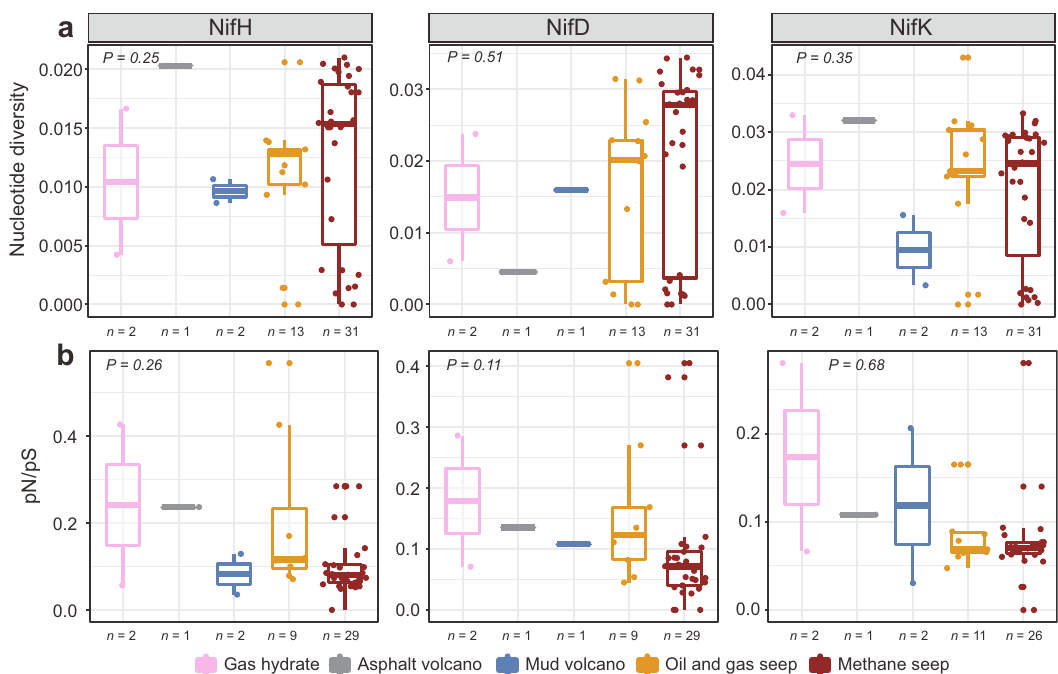
Fig. 7 | Evolutionary metrics of nitrogen fi xation genes. a Nucleotide diversity ( π ) of nifHDK genesatdifferent typesof coldseeps; b pN/pS ratio of nifHDK genes at different types of cold seeps. Nucleotide diversity is used to measure genetic diversity within a population (microdiversity), which is calculated using the for- mula: 1 − [(frequency of A) 2 +(frequency of C) 2 +(frequency of G) 2 +(frequency of T) 2 ]. pN/pS is the ratio of non-synonymous to synonymous polymorphism rates